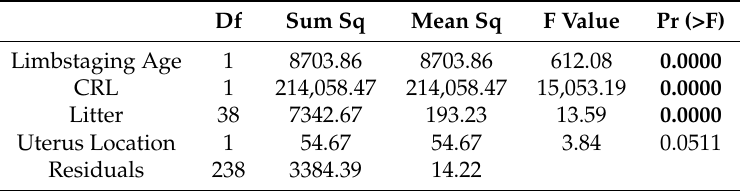
Figure 4. Deviation between age at harvest and limbstaging age for E12–E15. Each column represents a litter, with each data point representing an individual embryo. Colors represent age at harvest. Scores on the y -axis represent the difference between the expected age of an embryo based on age at harvest and limbstaging age for each individual. Table 3. ANOVA for limbstaging Age. Statistically significant p -values bolded . Df Sum Sq Mean Sq F Value Pr (>F)